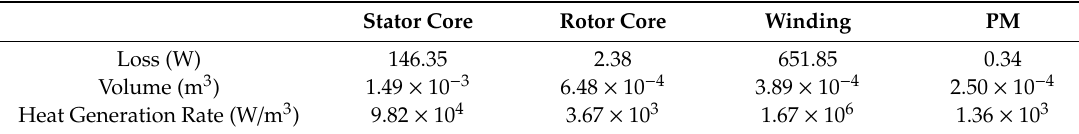
Table 4. The heat generation rate of each part. Stator Core Rotor Core Winding